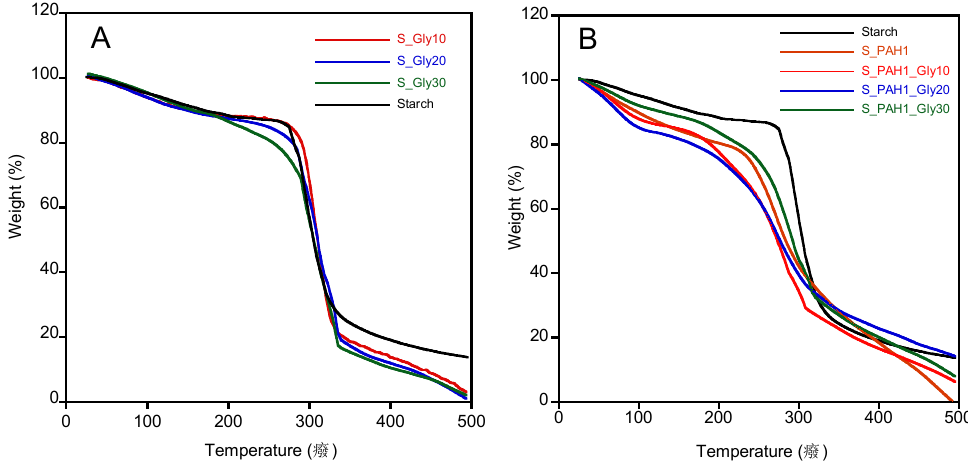
Figure 5. Thermogravimetric curves of S_GlyX ( A ) and S_PAH1-GlyX ( B ) films. In the thermogram of the native starch film, a first weight loss of 10% is observable at around 100 °C related to evaporation of absorbed water and a second weight loss at ca.